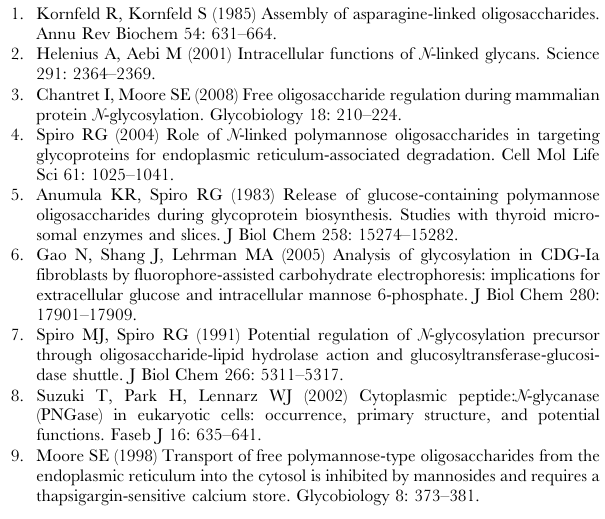
Table S1 Primers used in this study Found at: doi:10.1371/journal.pone.0011734.s001 (0.03 MB Figure S1 Inhibition of ENG1 gene expression induced by siRNA in HepG2 cells - Cells were transiently transfected with 1, 10 and 100 pmoles of either negative control RNAi duplexes or 3 sets of ENG1 RNAi duplexes (ENG-1, ENG-2 and ENG-3). Total mRNA were extracted 3 days later and ENGASE mRNA levels were quantitated by QPCR as described in Material and Methods.